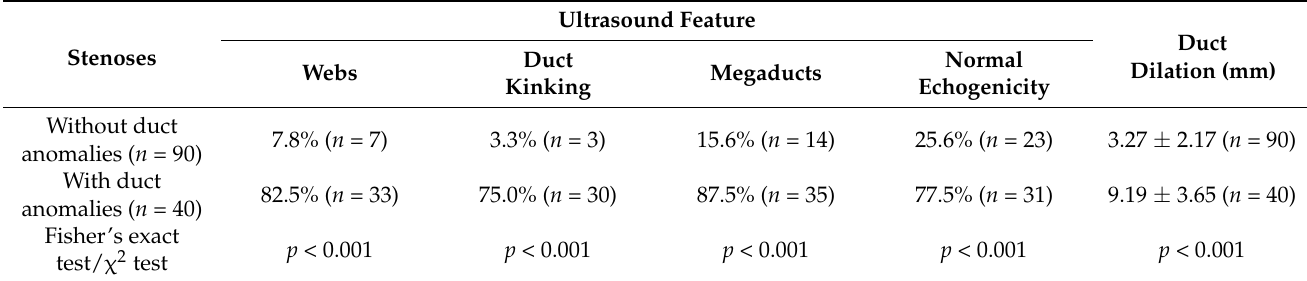
Figure 8. ( A , B ) Two examples of ductal stenosis within the Stensen’s duct system. ( A ) indicates a massive duct dilation measuring 7.3 mm (dotted lines) at the transition of the distal to the middle part in a left PG. The duct lumen could not be clearly identified more distally to this region (white arrow). Figure ( B ) shows a massive change in the caliber of the duct at the transition of the middle to the proximal duct system. While the proximal diameter can be measured (7.1 mm, dotted line), a ductal lumen is much more difficult to identify distally. In both cases, the location of the stenosis can be estimated, distally in ( A ) and proximally in ( B ). Table 1. Ultrasound Features of Stenoses Associated with Ductal Anomalies and Stenoses without Duct Anomalies (according to Goncalves and Koch et al.